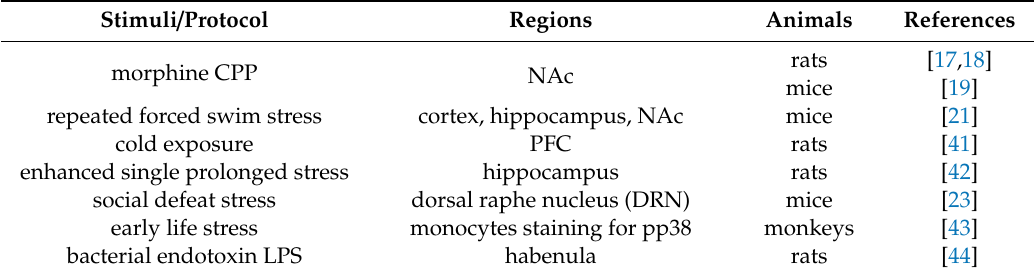
Table 2. Summary of the findings reporting the activation p38 MAPK after CPP to drugs and exposure to